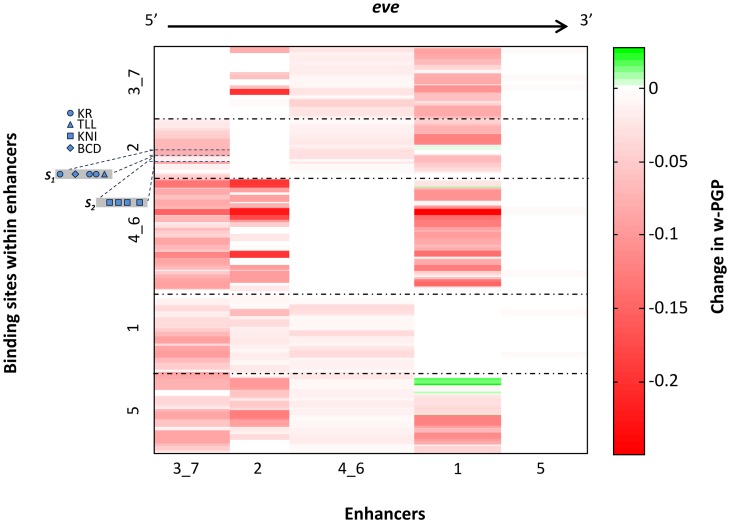
A heatmap visualization of the changes in GEMSTAT-GL's goodness-of-fit owing to interactions between the enhancers selected for the eve gene.The heatmap has 5 columns and  rows, where  denotes the total number of binding sites in the five eve enhancers. Each row in the heatmap represents a binding site; the ordering of the rows, from top to bottom, reflects the 5′ to 3′ order of the respective binding sites in the locus. Each horizontal dot-dash line demarcates binding sites from two different enhancers. Each column in the heatmap represents an enhancer; the columns are ordered, from left to right, according to the 5′ to 3′ order of the corresponding enhancers in the locus. The cell at row i and column j represents, on a green-to-red color scale (green: high, red: low), the effect of allowing the binding site i to interact with enhancer j. This effect quantifies how the goodness-of-fit improves (green) or decreases (red) when interactions are allowed (see Materials and Methods for details). Two segments S1 and S2 within the eve stripe 2 enhancer are shown on the left of the heatmap, along with their constituent binding sites for TFs KR, TLL, KNI, BCD. Each of these segments has binding sites that, when allowed to interact with the eve_3_7 enhancer, result in poorer fits.